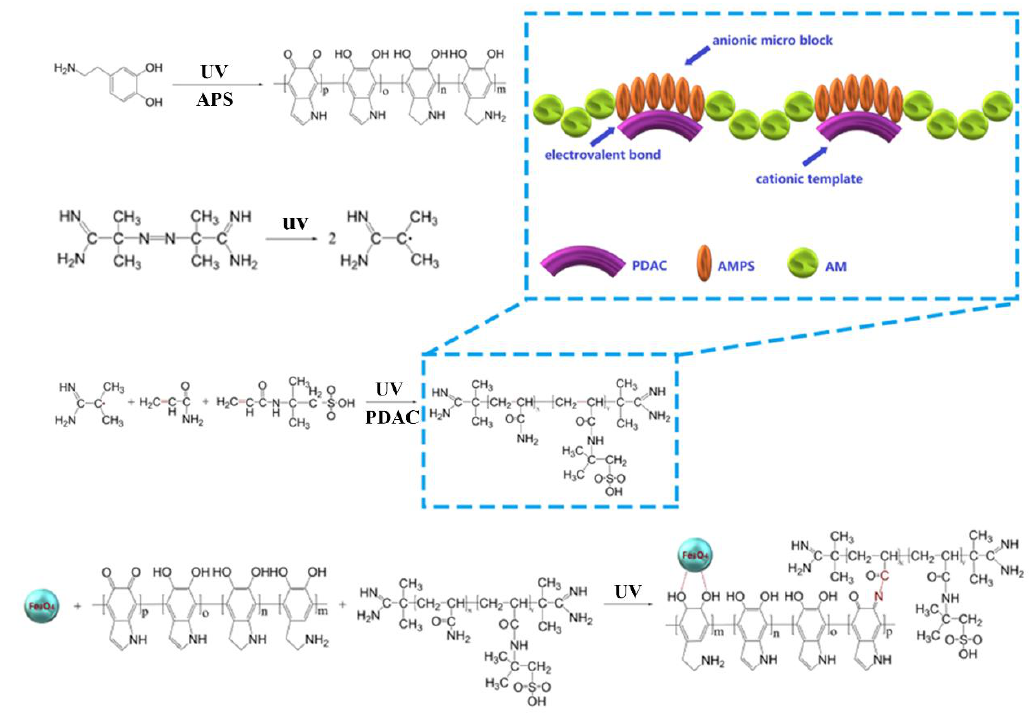
Figure 1. The scheme of preparing TAPAM-PDA-Fe 3 O 4 .